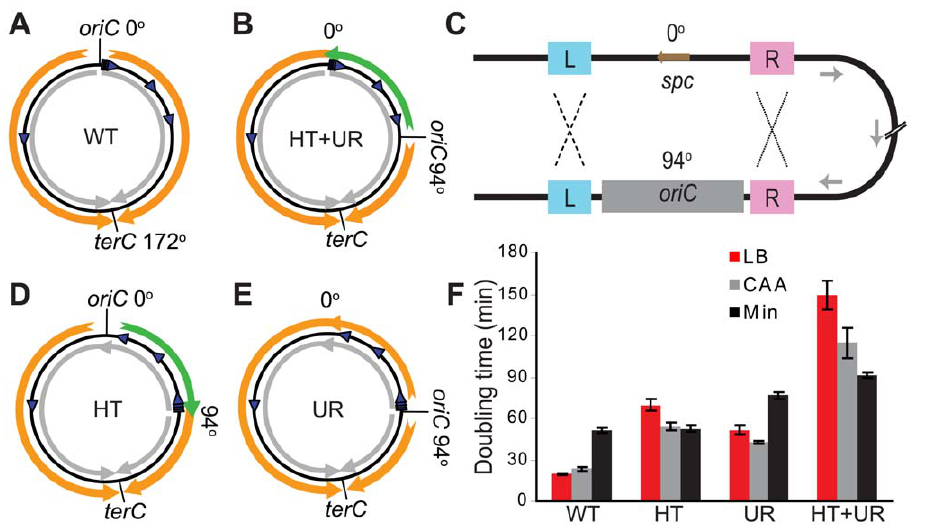
Figure 1. Alteration of different aspects of genome organization results in different growth defects. (A) Schematic diagram of the wild type B. subtilis chromosome (black circle). oriC at 0 u and terC at 172 u represent the origin and terminus of DNA replication, respectively. Orange arrows: replication; grey arrows: predominant direction of transcription; blue arrowheads: rRNA operons. (B) Schematic diagram of a mutant chromosome with oriC relocated to 94 u [31], resulting in head-on transcription and unequal replichores (HT + UR). Green arrow: replication head-on to transcription between 0 u and 94 u . (C) Schematic diagrams of homologous recombination events leading to inversions of J of the chromosome. L and R: sequences flanking oriC that are repeated at 0 u and 94 u ; spc : spectinomycin resistance gene, which was inserted to replace the endogenous oriC at 0 u [31]. Recombination at L (dashed lines) and R (dotted lines) give rise to the chromosomes shown schematically in (D,E), respectively. (D) Schematic diagram of the chromosome with an inversion between 0 u and 94 u resulting in head-on transcription (HT). (E) Schematic diagram of the chromosome with an inversion between 0 u and 94 u resulting in unequal replichores (UR). (F) Doubling times at 37 u C in liquid LB (red bars), minimal medium with (CAA, grey bars) or without (Min, black bars) casamino acids, calculated by measuring OD 600 . Data shown are for strains in the JH642 background.